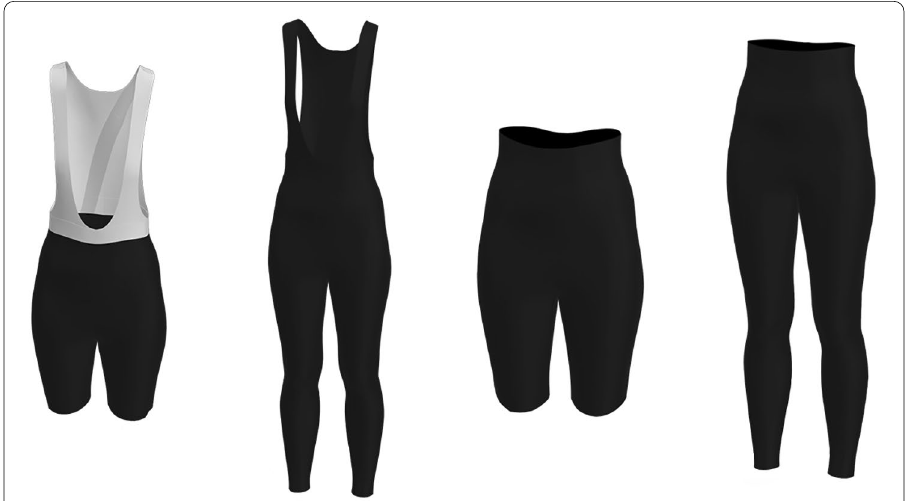
Fig. 1 Types of cycling pants (Reprinted from https:// bike. shima no.